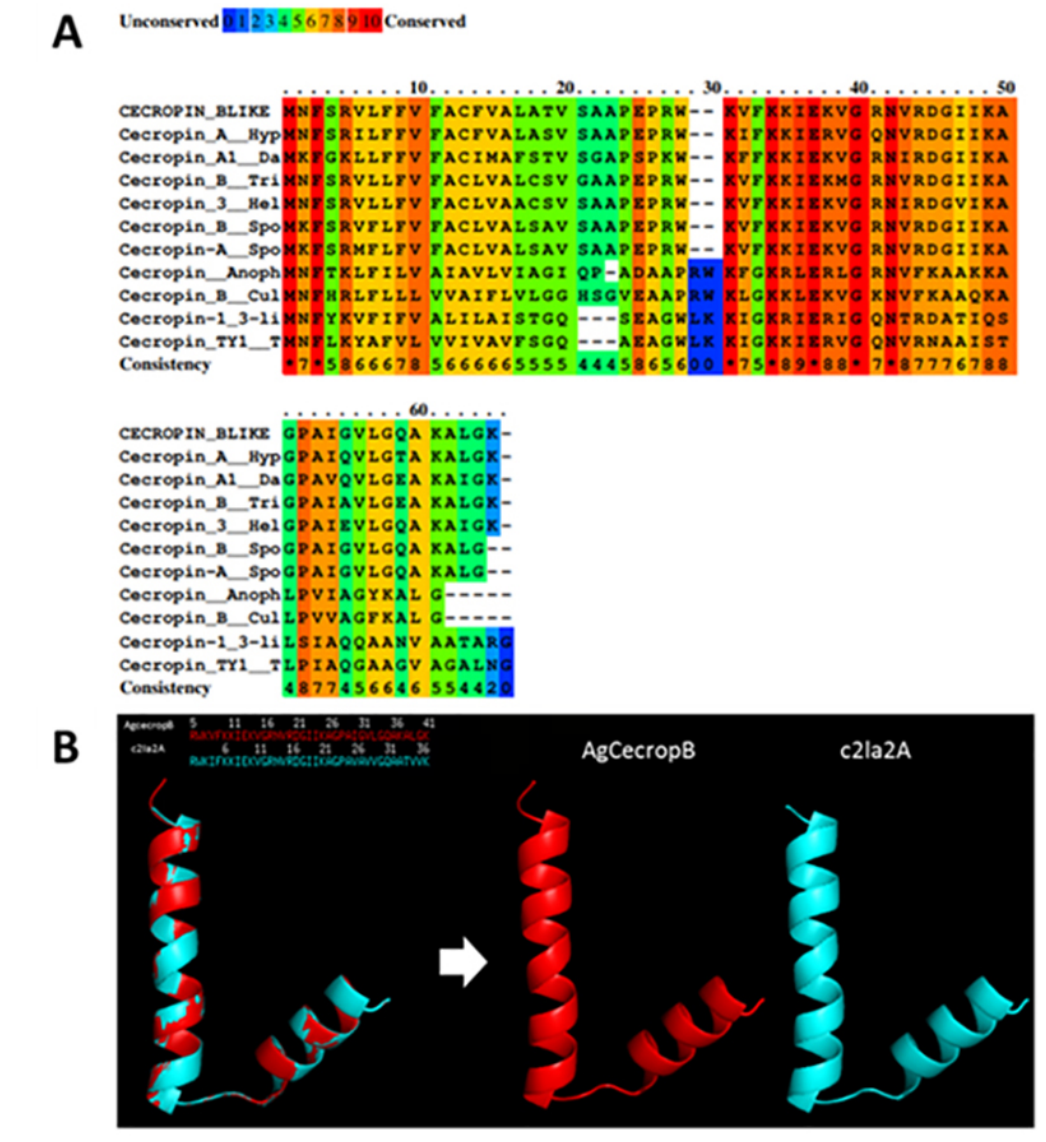
Figure 2. AgCecropB pre-pro-peptide primary sequence alignment and tertiary structure modeling. (A) PRALINE alignment result using AgCecropB pre-pro- peptide sequence identified in transcriptome and other lepidoptera and diptera cecropins sequences deposited in GenBank. CECROPIN_BLIKE: Cecropin B pre- pro-peptide from A. gemmatalis transcriptome (GenBank database code MW330381); Cecropin_A_Hyp: Cecropin A from Hyphantria cunea ; Cecropin_A1_Da: Cecropin A1 from Danaus plexippus plexippus ; Cecropin_B_Tri: Cecropin B from Trichoplusia ni ; Cecropin_3_Hel: Helicoverpa armigera Cecropin 3; Cecropin_B_ Spo: Cecropin B from Spodoptera exigua ; Cecropin-A_Spo: Cecropin A from Spodoptera litura ; Cecropin_Anoph: Anopheles darling cecropin; Cecropin_B_Cul: Cecropin B from Culex quinquefasciatus ; Cecropin-1_3-li: Drosophila hydei 1/3-like cecropin; Cecropin_TY1_T: Tabanus yao cecropin 1. (B) Overlapping of the tertiary structure models of cecropin B-like peptide and papiliocin c2la2A. Papiliocin c21a2A isolated from Papilio xuthus was the suggested template by Phyre2 for AgCecropB tertiary structure modeling. PyMOL generated the overlapping model based on both peptides mature